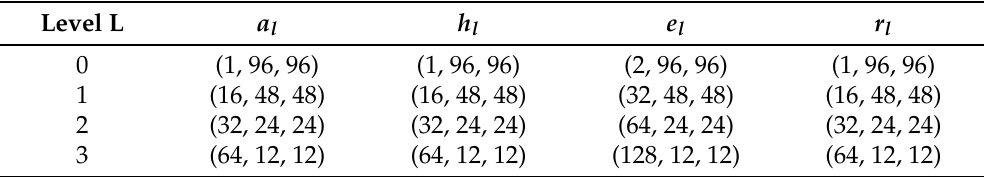
Table 2. PredNet tensors: size of the tensors for the different levels of the PredNet architecture expressed as (channels, width, height).